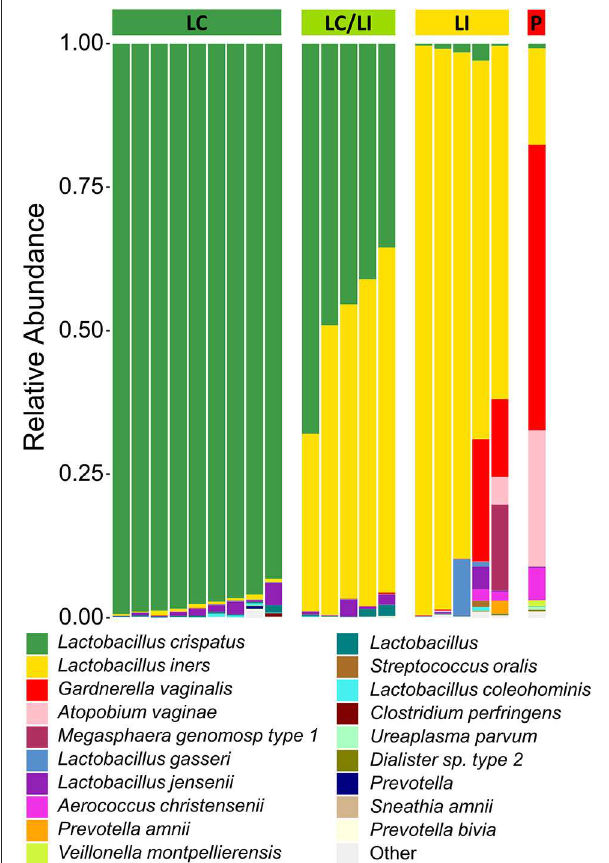
FIGURE 1 | Stacked bar graph of vaginal bacteria phylotypes as determined by 16S rDNA sequencing of CVS. Samples are organized according to community state types (CSTs) as indicated by the colored bar on top of the graph. From left to right, green = L. crispatus (LC); yellow-green = L. iners / L. crispatus mix (LI/LC); yellow = L. iners (LI); red = polymicrobial (P). Each column represents an individual sample ( n = 20 total). The height of each color indicates the relative abundance of a specific bacterial phylotype, as indicated in the legend. The top 19 abundant phylotypes are included, with all additional phylotypes summed and labeled as